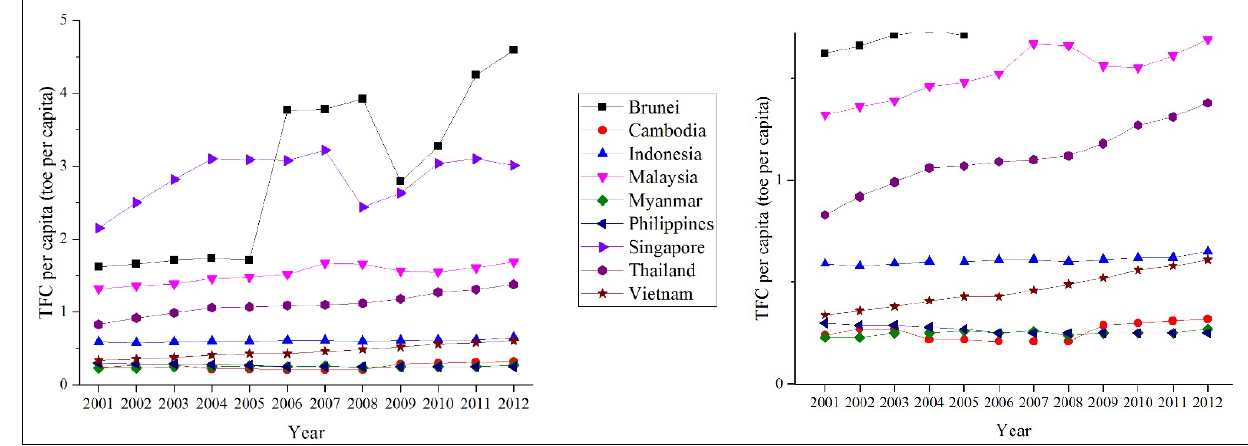
Figure 26. Total final consumption per capita.